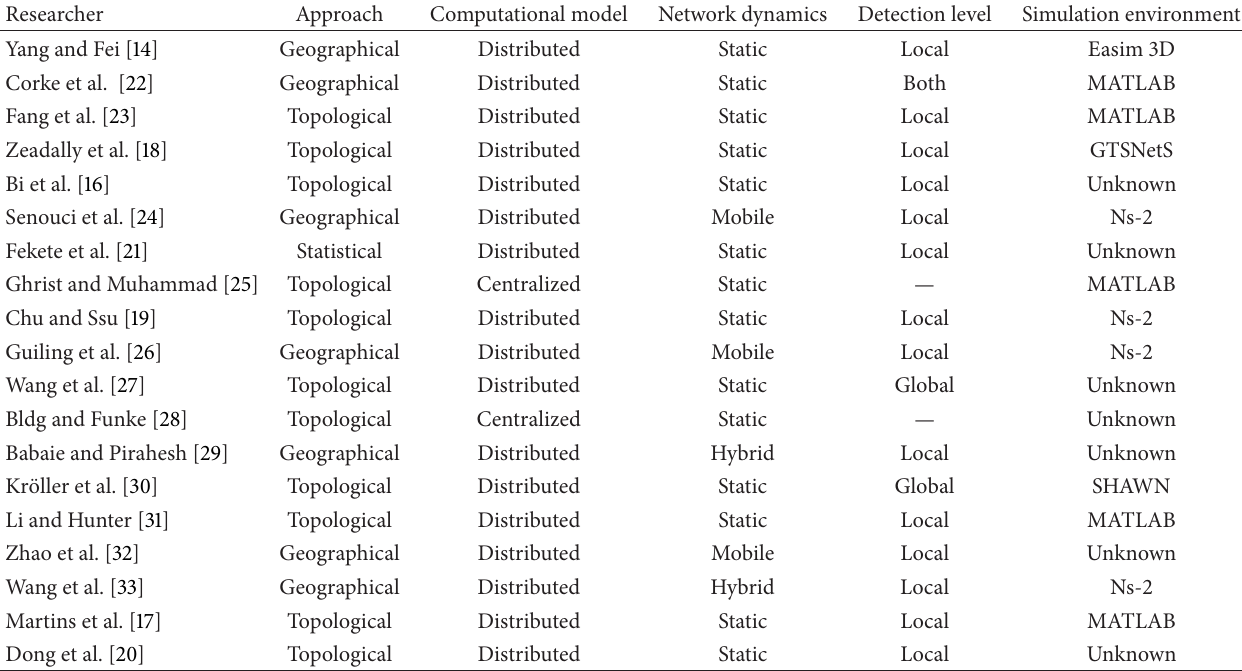
Table 1: Characteristics of various coverage hole detection